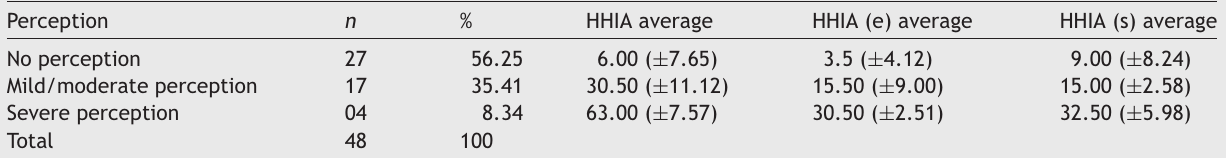
Number of cases, percentages, total averages and of emotional and social domains according to the degree of perception of hearing handicap measured by HHIA.